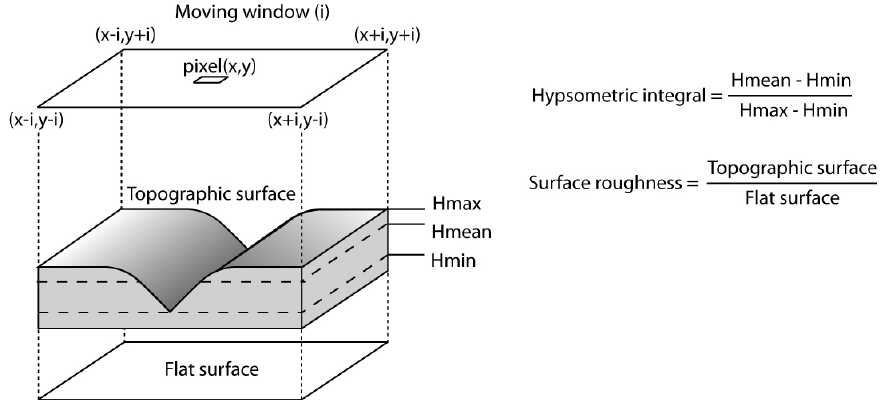
Figure 4. Surface indices. Calculation of the hypsometric integral and surface roughness within a moving window of size (i). Both values are assigned to the central pixel (x,y) of the output